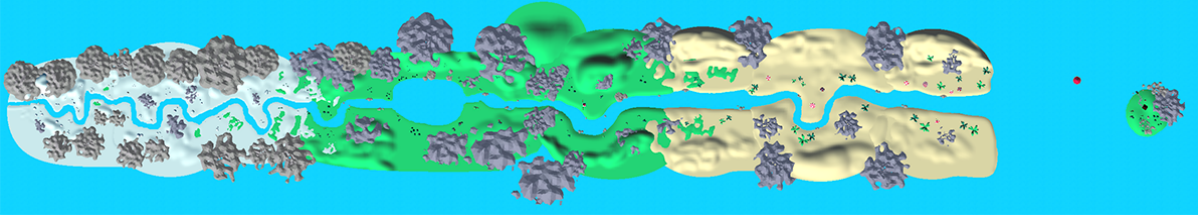
Figure 2. The environment design of Breeze is depicted. It starts in a snowy environment, passes into a grass-overgrown environment, and passes the sandy beaches before leading into the open